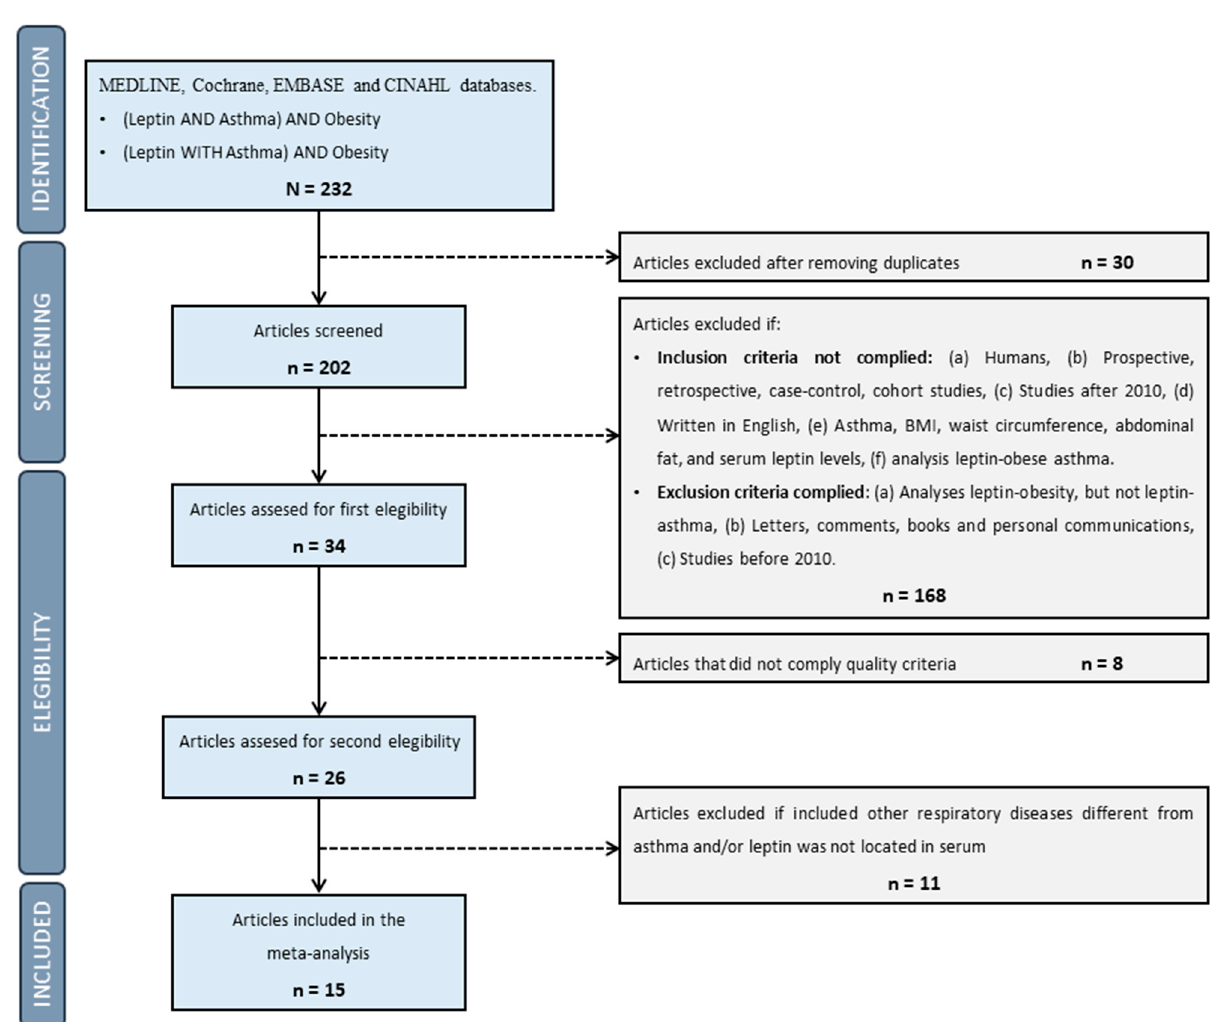
Figure 1. Study selection process for the meta-analysis review related to the role of leptin in asthma.